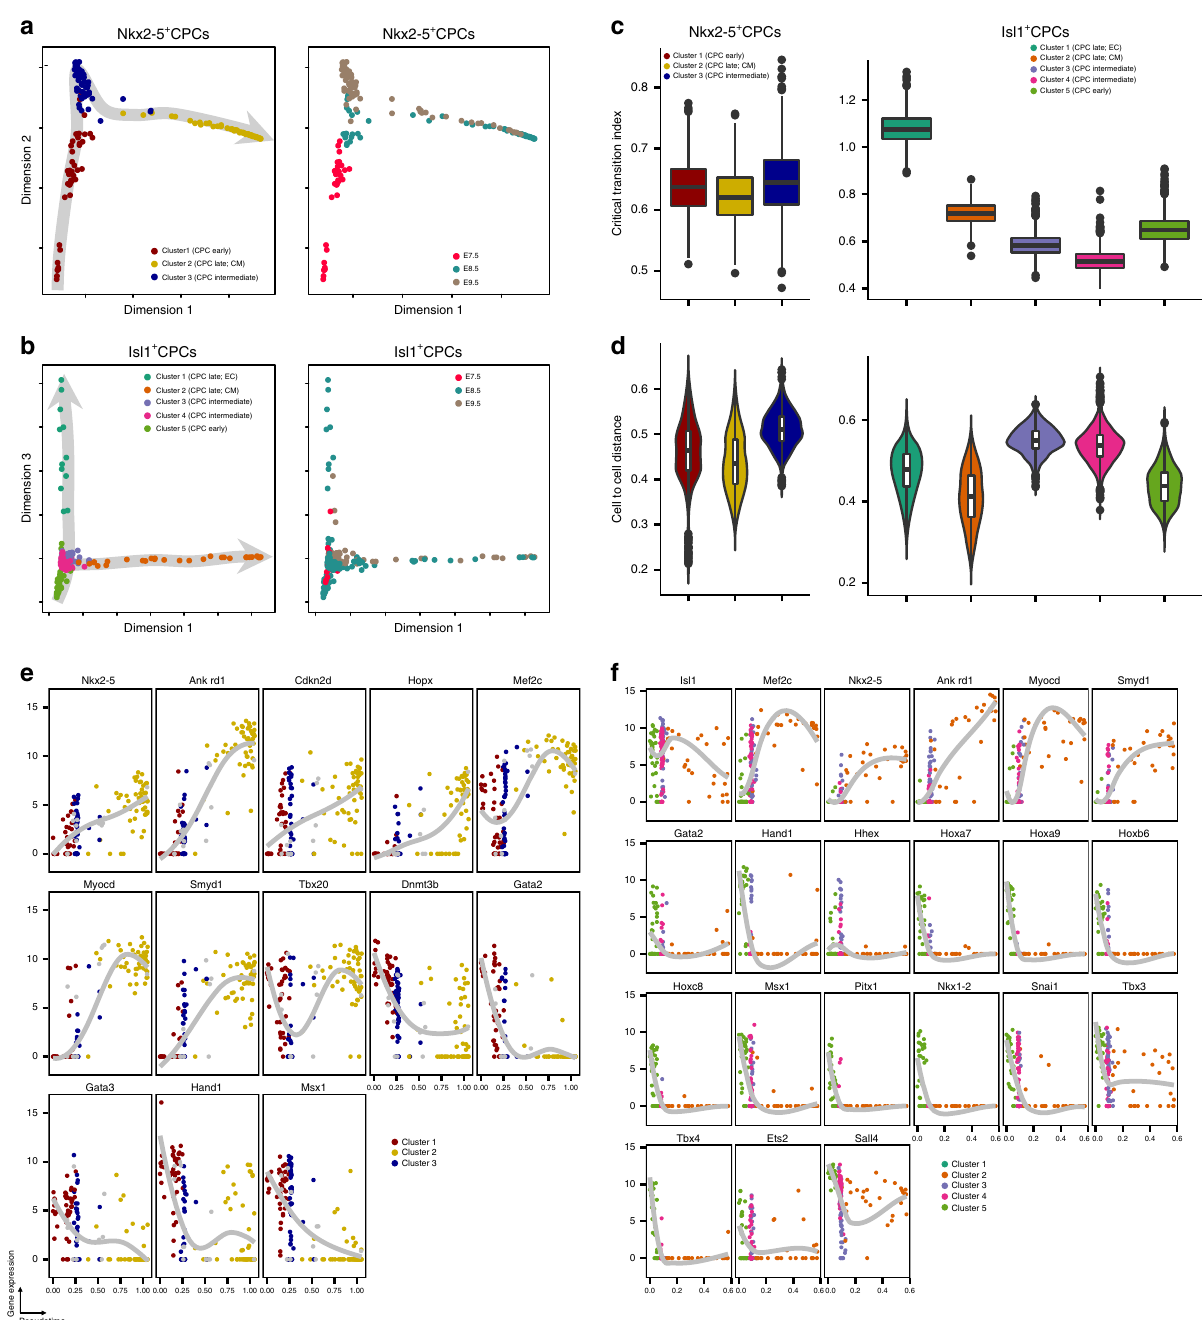
Fig. 2 Reconstruction of trajectories and transition states of CPCs. a t-SNE plots showing diffusion pseudotimes (gray arrows) of Nkx2-5 + and b Isl1 + CPCs. Clusters and development stages of individual cells are color-coded as indicated. c Boxplots representing the distribution of I C (C) values from all marker genes for each cluster of Nkx2-5 + (left) and Isl1 + (right) cells. Lower and upper hinges correspond to the fi rst and third quantile (25th and 75th percentile), while whiskers extend from the hinge to the smallest (largest) datum not further than 1.5 times the interquartile range. Outliers are plotted individually. d Violin plots showing the distribution of pairwise cell-to-cell distances across each cluster of Nkx2-5 + (left) and Isl1 + (right) cells. Inset boxplots show the median, lower and upper hinges as well as whiskers and outliers as in ( c ). e, f Expression levels of different transcription factors and key marker genes on the pseudotime axis in Nkx2-5 + ( e ) and Isl1 + ( f ) cells. Trend lines calculated by Loess regression are indicated in gray. Source data for ( c – f ) are provided in the Source Data fi Isl1 -knockout cells compared to wild-type cells, although the Isl1 nGFP/nGFP embryos and isolated Isl1-GFP + cells by FACS results did not reach statistical signi fi cance ( χ 2 test: p = 0.062) analysis at E9.5 (Fig. 5a). Projection of Isl1 -KO single cells on the trajectory of the developing SHF revealed that Isl1-KO cells are (Fig. 5c). We concluded that proliferation defects might con- stalled/trapped in the previously identi fi ed stable attractor state tribute to the attractor state of Isl1 -knockout cells but that (Fig. 5b). Analysis of G1/S and G2/M cell cycle markers in single additional biological processes probably play more important cells (Supplementary Fig. 9a – c) suggested reduction of cycling roles. To identify such processes, we performed gene ontology